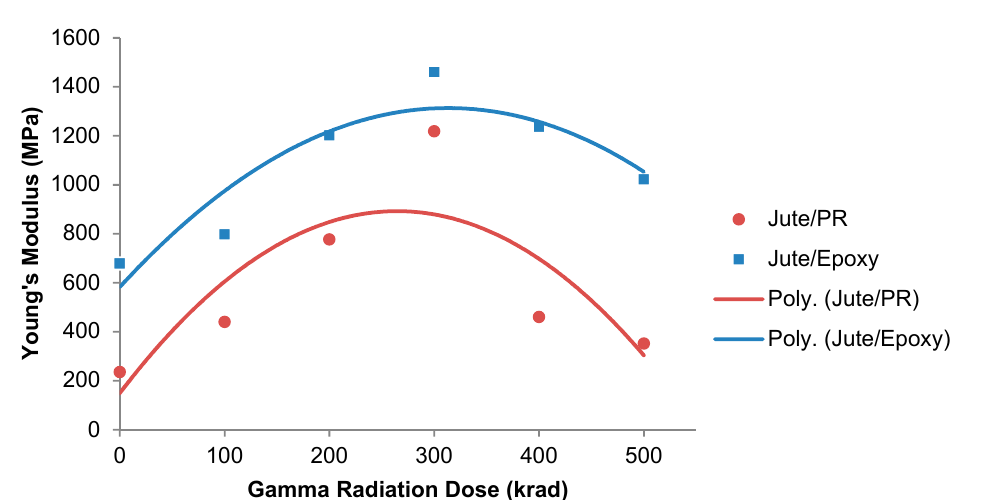
Figure5. Gammaradiatione ff ectsontheYoung’smodulus(Y)oftheJute / PRandJute / Figure 5. Gamma radiation effects on the Young’s modulus (Y) of the Jute/PR and Jute/Epoxy composites.